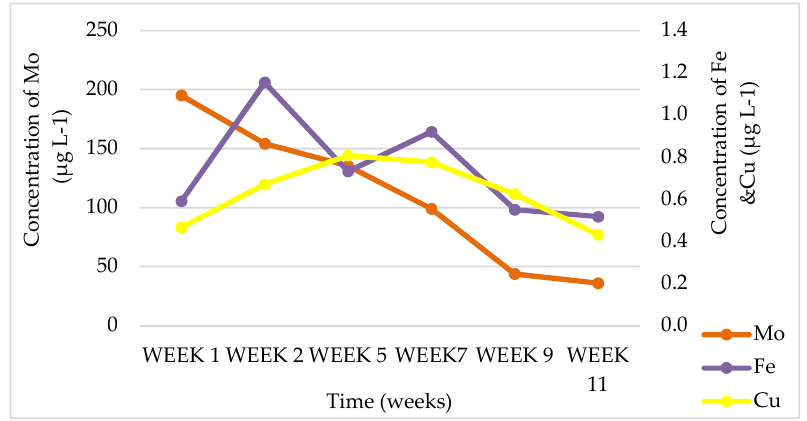
Figure 11. Chemical-element concentrations obtained from CFA (Coal-fly-ash) pots where no plants were grown for essential elements Fe, Mo, and Cu.